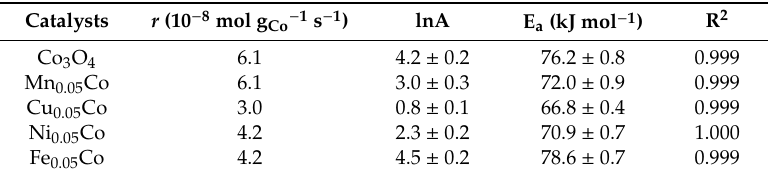
Table 6. Reaction rates (r) at 160 °C, apparent pre-exponential factors (A), apparent activation energies (E a ), and coefficient of determination (R 2 ) for propane oxidation over various catalysts (reaction conditions: propane concentration = 1000 ppm, O 2 concentration = 21 vol.% and WHSV = 40,000 mL h −1 g −1 ).